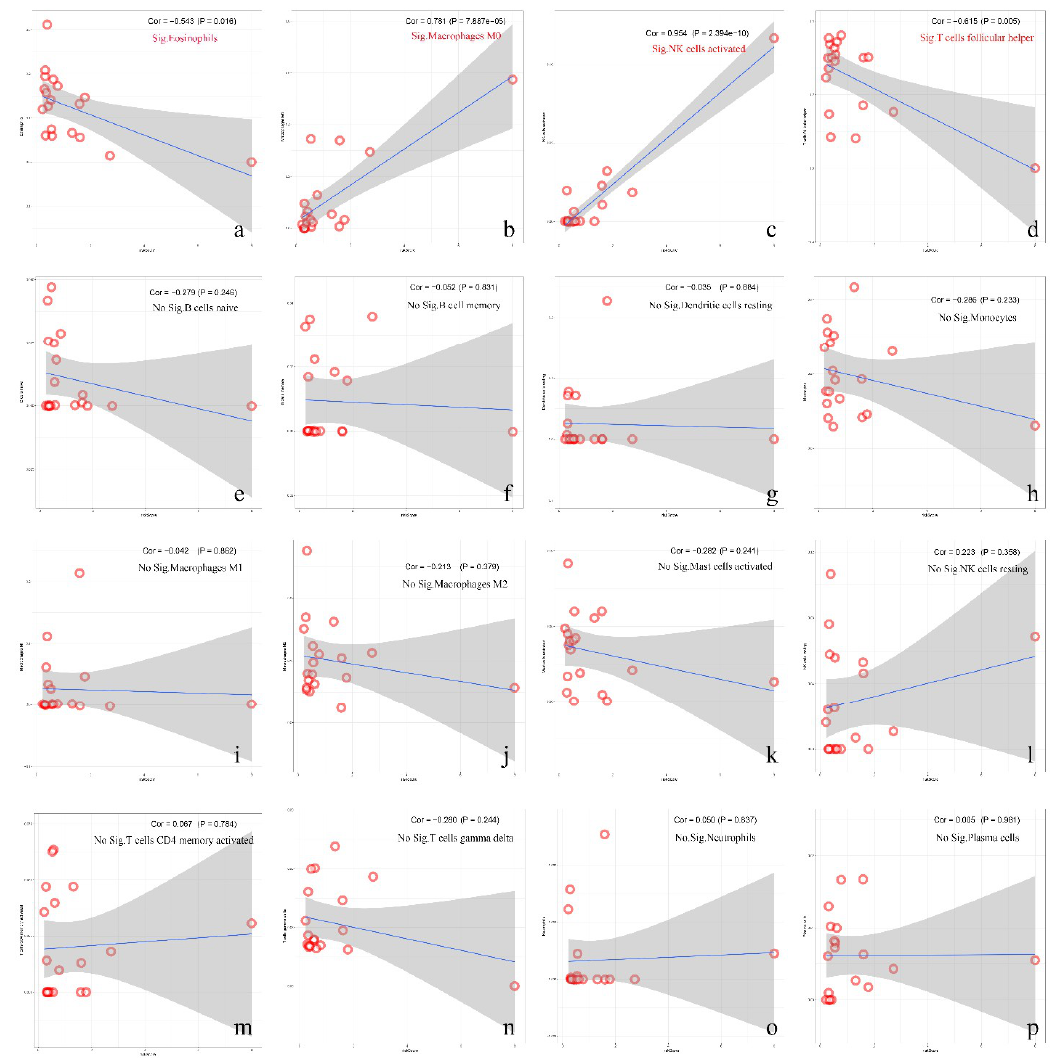
Figure 7. The correlations between immune infiltration cells and risk scores. Significant di ff erences are shown in graph ( a – d ) ( p < 0.05). However, in ( e – p ), there was no statistical